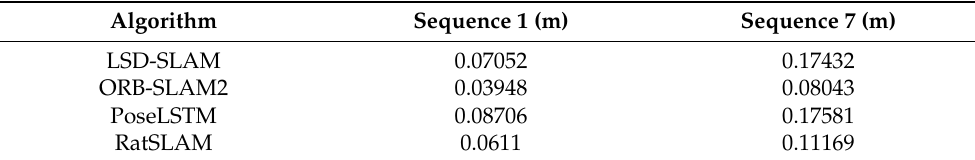
Table 1. Vision-only methods positioning accuracy comparison.